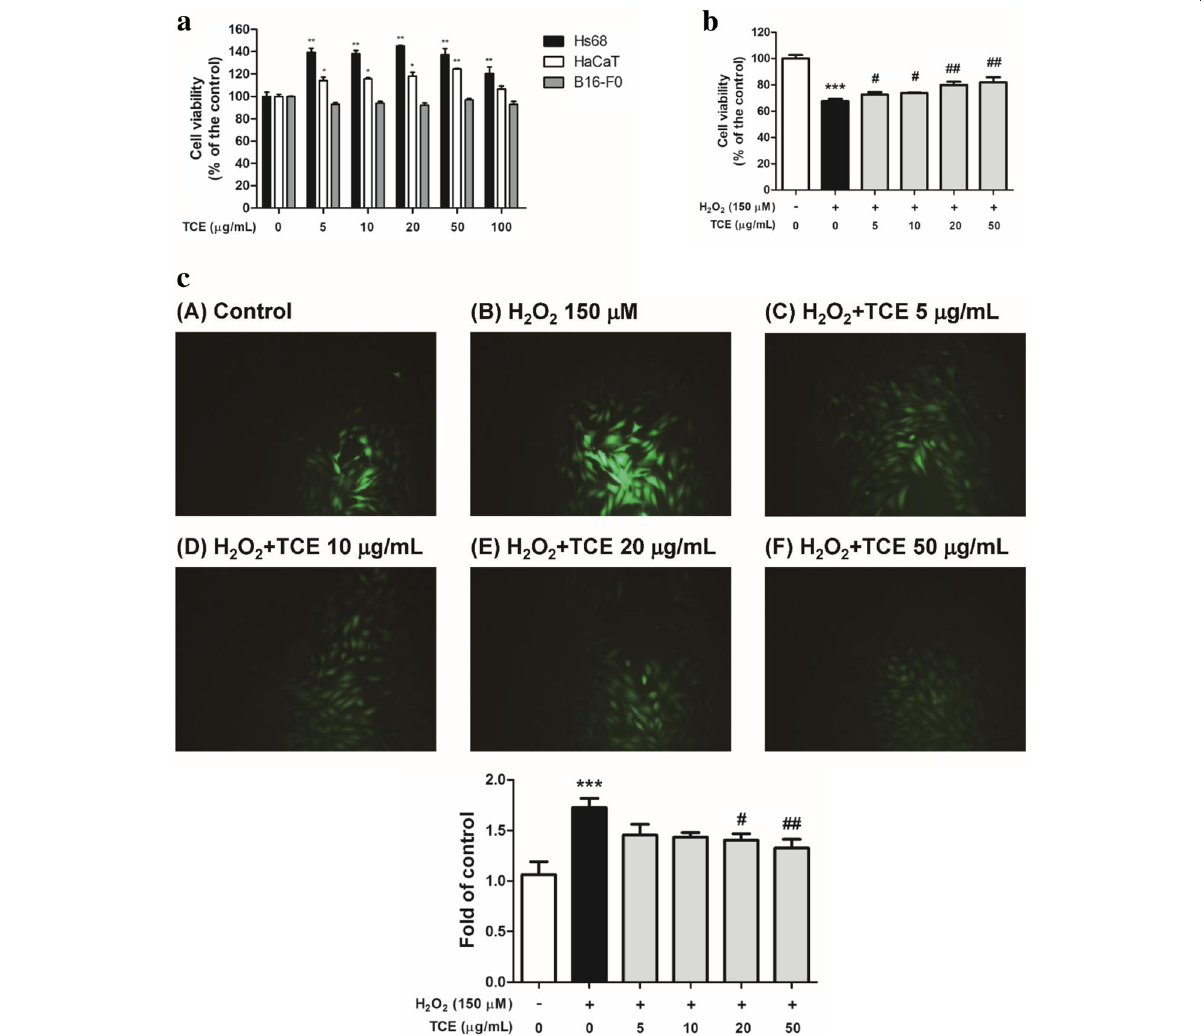
Fig. 2 The cytotoxicity and effect on intracellular oxidative stress in Hs68 of TCE. a Cell viability (%) of human fibroblasts (Hs68), human keratinocytes, and mouse melanoma cells treated with TCE; b Cell viability of Hs68 after treatment with TCE with or without 150 μ M hydrogen peroxide (H 2 O 2 ) exposure. c Repressive effect of TCE on H 2 O 2 -induced intracellular oxidative stress in Hs68. Significant difference versus control: * p < 0.05; ** p < 0.01; *** p < 0.001. Significant inhibition versus H 2 O 2 -exposed group: # p < 0.05; ## p <